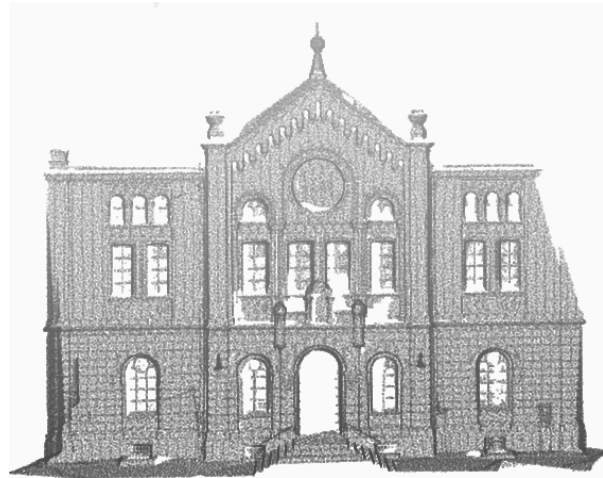
Figure 1. Section of the point cloud showing the entrance to the synagogue from an impulse terrestrial laser scanner